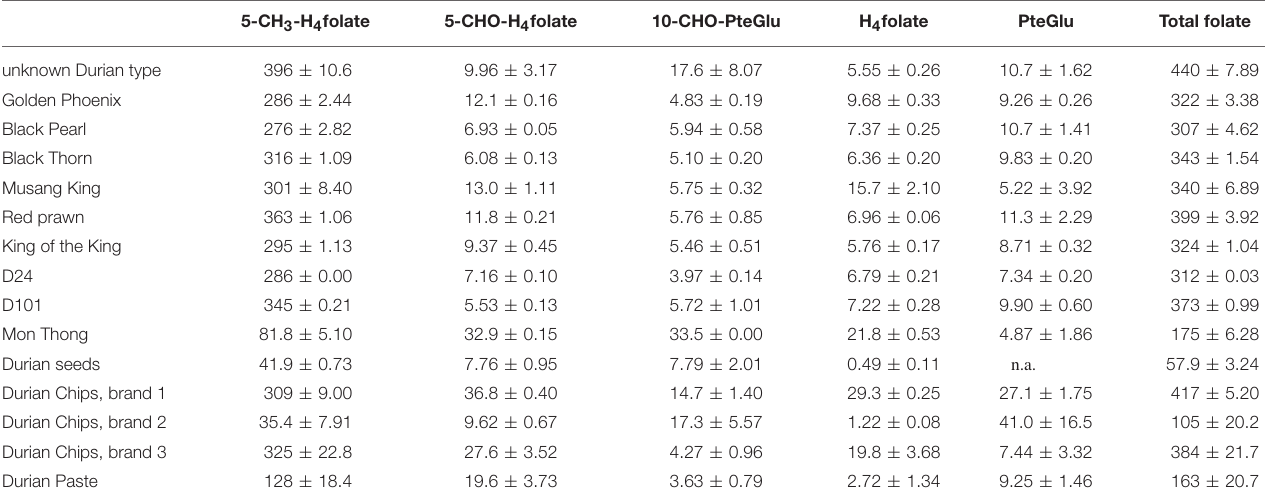
TABLE 1 | Total folate content and vitamer distribution in durian varieties, calculated as PteGlu in [ µ g/100g] on fresh weight